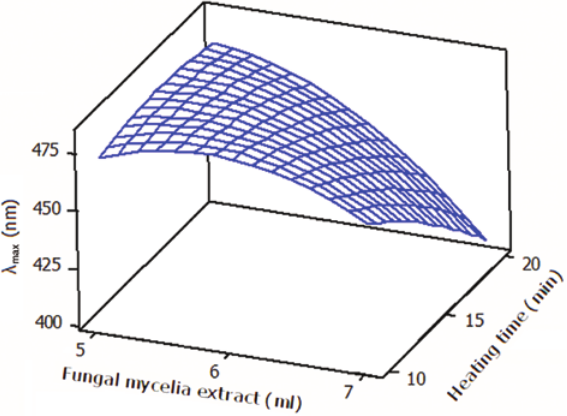
of the synthesized AgNP solution as a Figure 2: Surface plot for λ max function of the A. fumigatus mycelia extract and heating time.